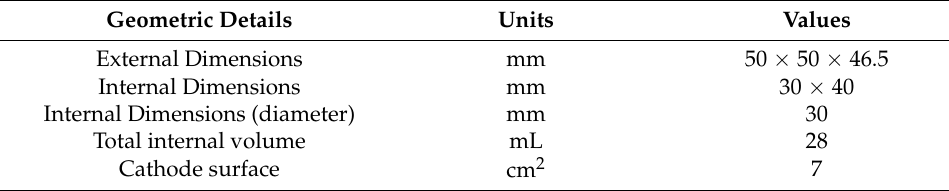
Figure 1. Reactors design: ( a ) Single chamber reactor, ( b ) multi-electrode reactor. Table 1. Geometric data of a single-chamber